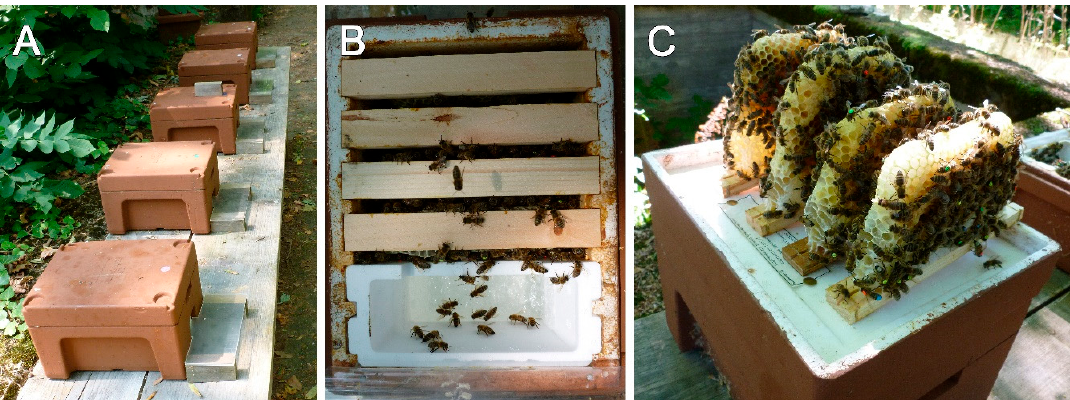
Figure 1. ( A ) Mini-hives of one treatment group including five colonies during GBH exposure. ( B ) Plan view of a mini-hive with four top-bars and a feeding device, providing space for an intact honey bee colony. ( C ) For the brood/survival assessments, all four combs were removed, and both sides of each top-bar were photographed without/with bees attached, respectively (see Sections 2.1.4 and 2.1.5).